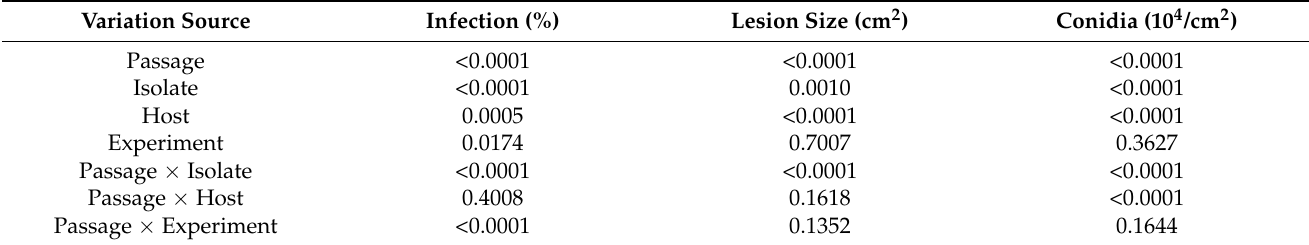
Table 3. Post-passage analysis of significance of factors affecting aggressiveness components of the selected Calonectria pseudonaviculata isolates from passages 0, V, and X on three hosts.